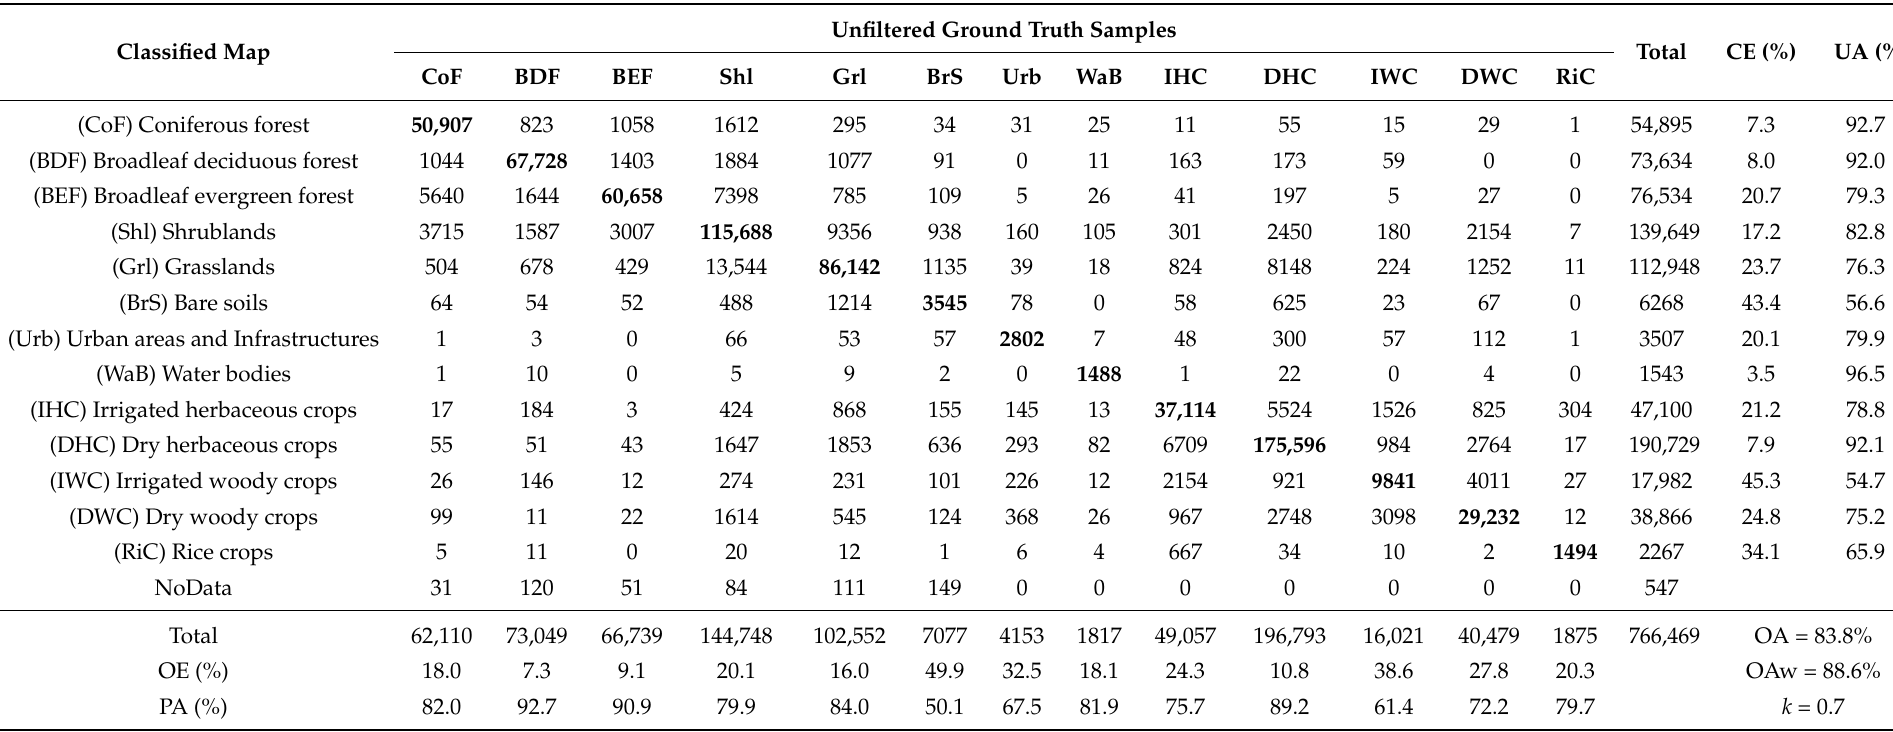
Table 2. Confusion matrix results derived from unfiltered ground truth samples from SIOSE 2005 rDS and imagery for